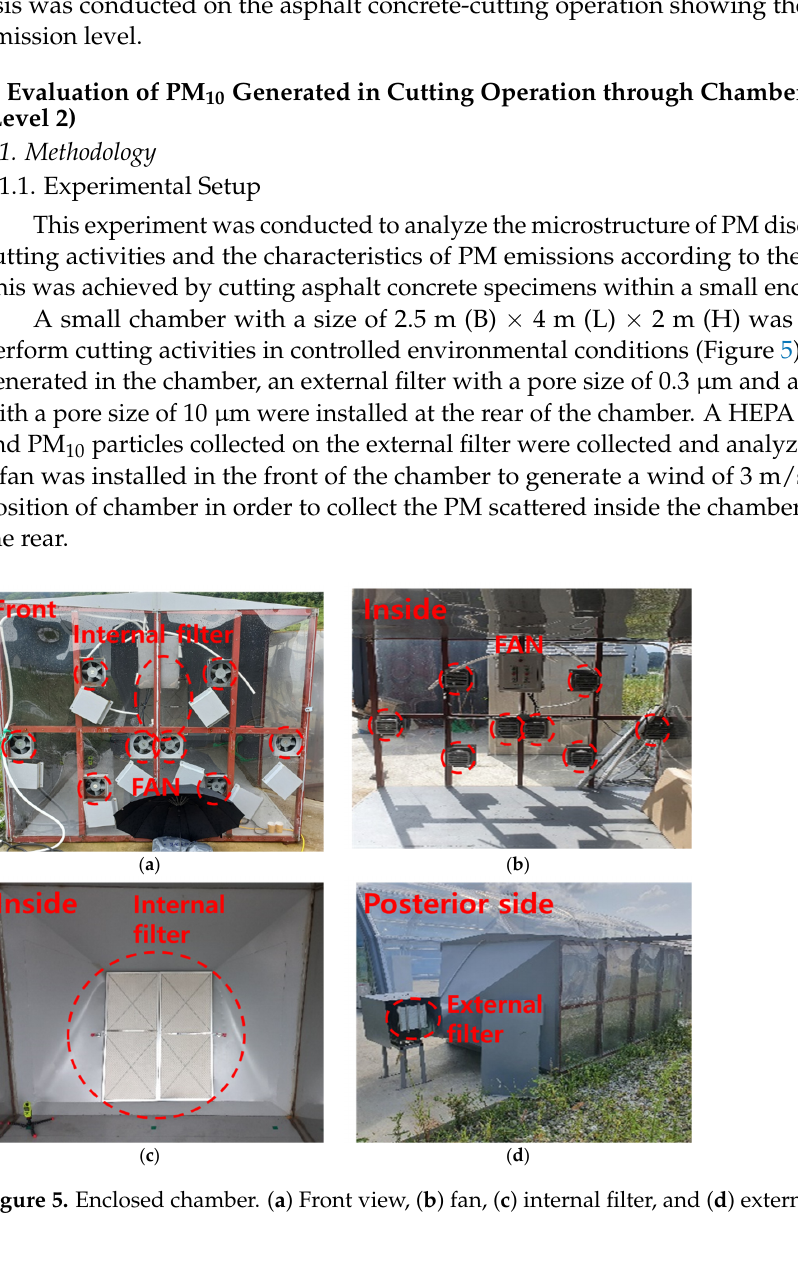
( b ) Figure 6. ( a ) Preparation of asphalt concrete specimen and ( b ) chamber experimental setup . The cutter used in the experiment was the equipment commonly used for small-scale road-cutting work. The maximum cutting depth is 150 mm, and dry cutting and wet cut- ting are possible. The experiment was conducted after placing the asphalt concrete speci- men and cutter inside the chamber, as shown in Figure 6b.